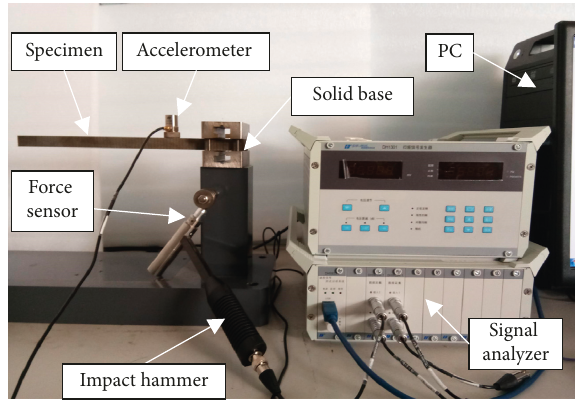
Figure 9: Experimental setup of cracked cantilever beam.